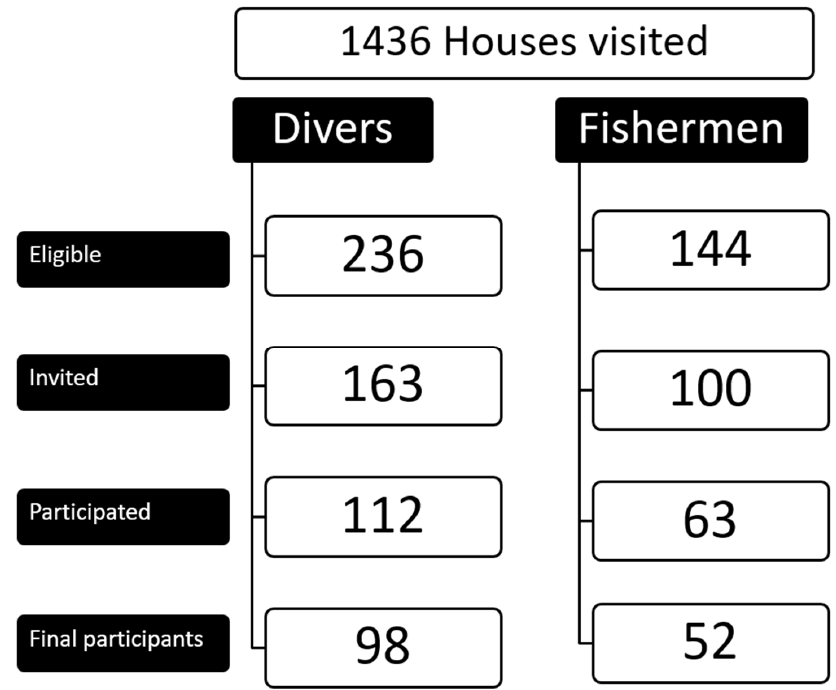
Figure 1. Flow chart of the recruitment process. The obtained data presented no statistically significant difference between the group of divers and fishermen considering residence, age, BMI, education and smoking, but di- vers were a bit smaller (mean = 168 cm) than fishermen (mean = 170 cm, p = 0.023; Table 1). Lung function parameters did not differ between divers and fishermen (Table 2). Half of the diving population already had more than 25 years of diving experience (Table 1). Almost half (48%) did 100–200 dives per year. Diving depths during the last 12 months reached down to 30 m for 60% of divers, while 14% dove deeper than 50 m. Table 1. Demography and health status of the divers and fishermen. Divers (N = 98)